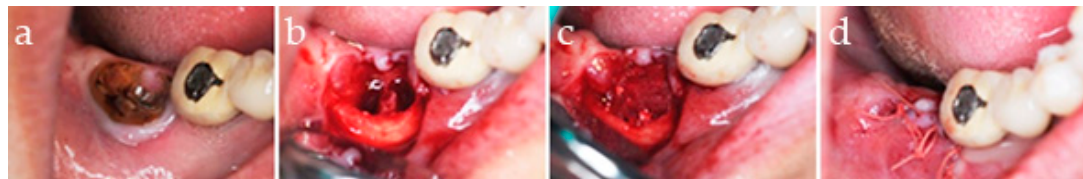
Figure 1. Surgical socket preservation with composite of hydroxyapatite/ β -tricalcium plus collagen (HA/ β -TCP + collagen). ( a ) Preoperative appearance. ( b ) Appearance immediately after extraction. ( c ) Socket filled with an HA/ β -TCP + collagen composite. ( d ) Appearance after suturing: complete socket closure.